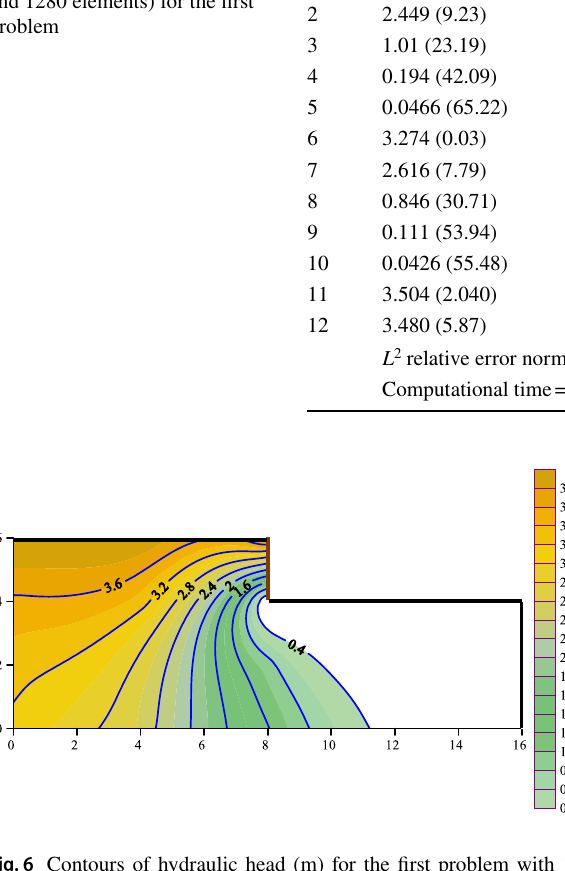
Table 2 Comparison of the results among Hankel shape function (10 elements) and Lagrange shape function (10 and 1280 elements) for the first problem